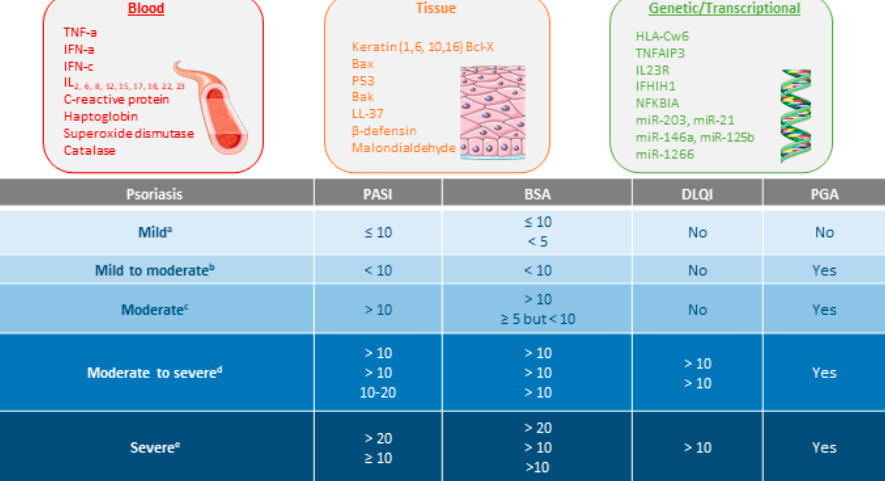
Figure 1. Types of biomarkers in psoriasis and psoriasis severity criteria according to several con- sensus guidelines or clinical associations. References supporting the consensus for a [20,21], b [22],